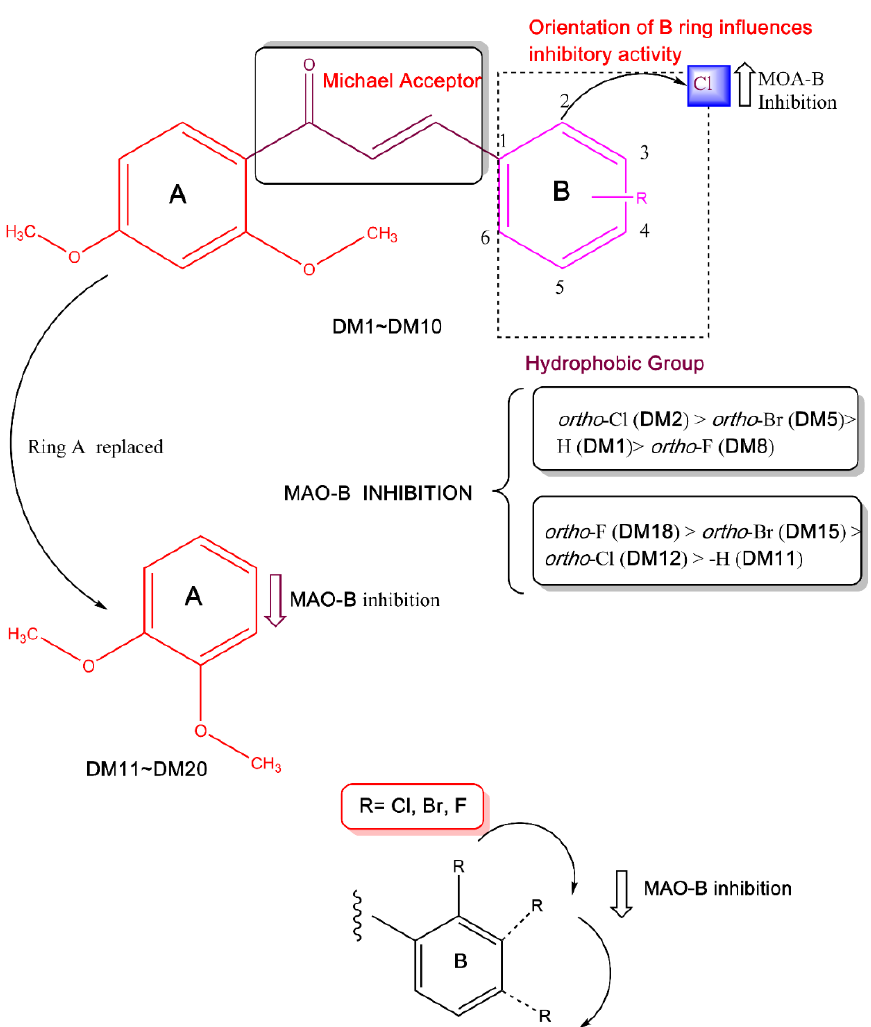
Figure 2. SAR of dimethoxylated halogen-containing chalcones.